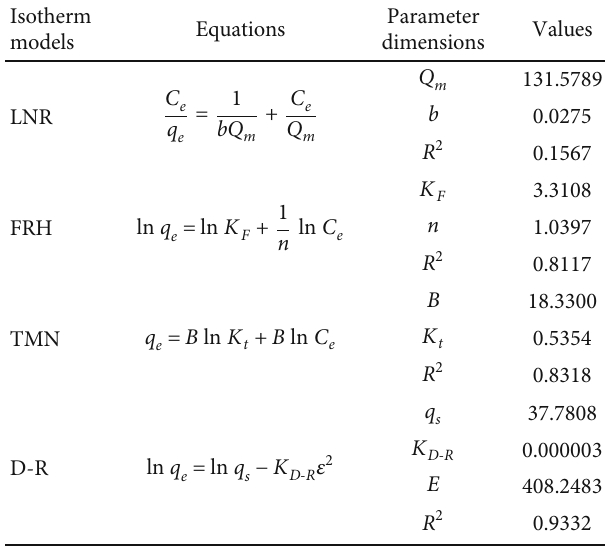
Table 2: The sorption isotherm models employed for this study. Isotherm